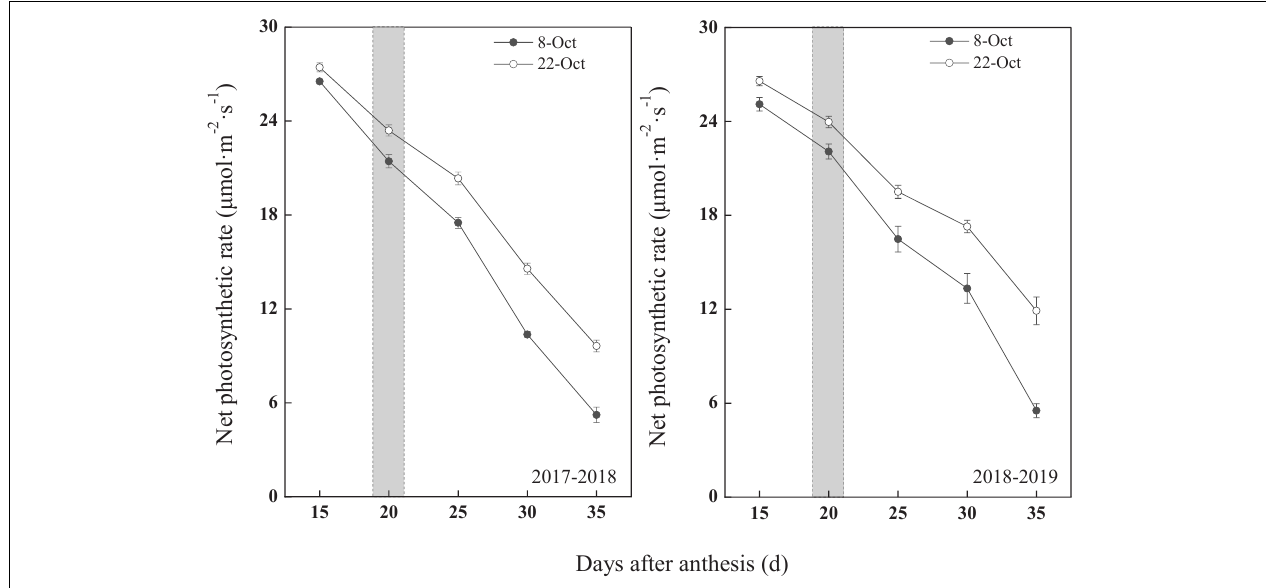
FIGURE 3 | Effect of delayed sowing on photosynthetic rate of wheat flag leaves under heat stress at late grain–filling stage. With a gray area from 19 to 21 DAA. Values are means of three replicates per treatment. Vertical bars indicate standard error.